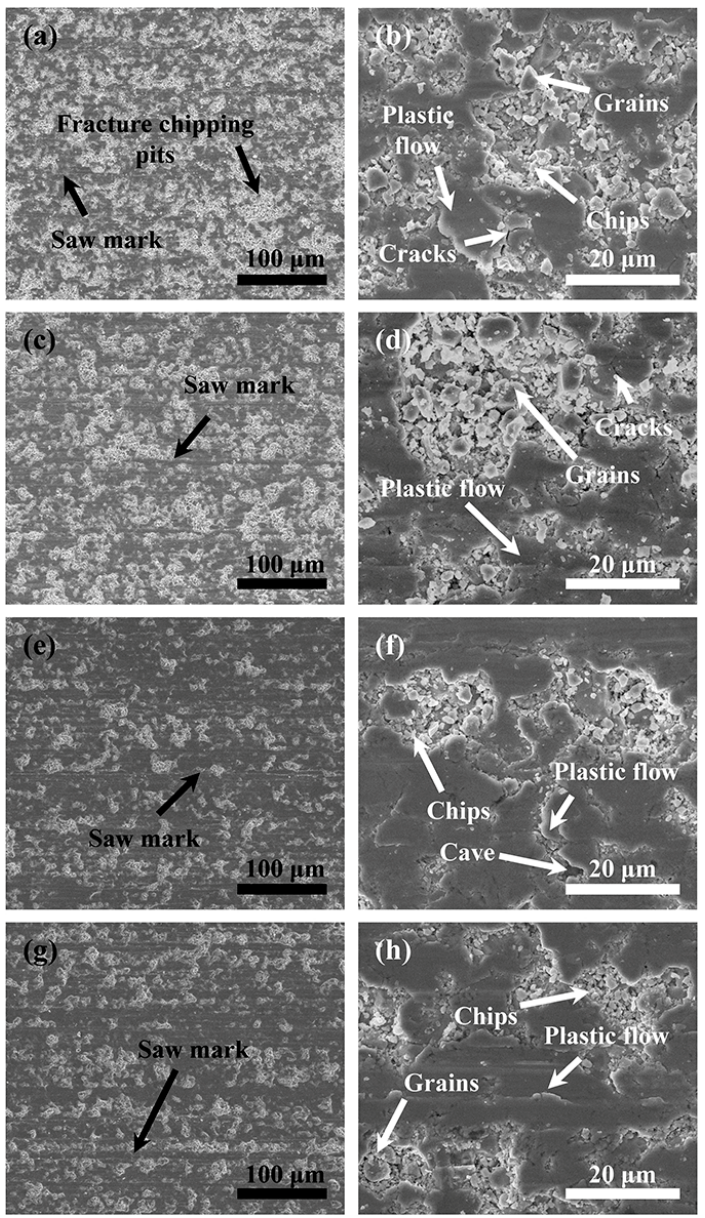
Figure 13. SEM images of the surface of samples sawed at different feed speeds at P = 0.21 MPa, v s = 1.8 m/s: ( a , b ) v f = 0.05 mm/min; ( c,d ) v f = 0.1 mm/min; ( e,f ) v f = 0.2 mm/min; and ( g,h ) v f = 0.3 mm/min.